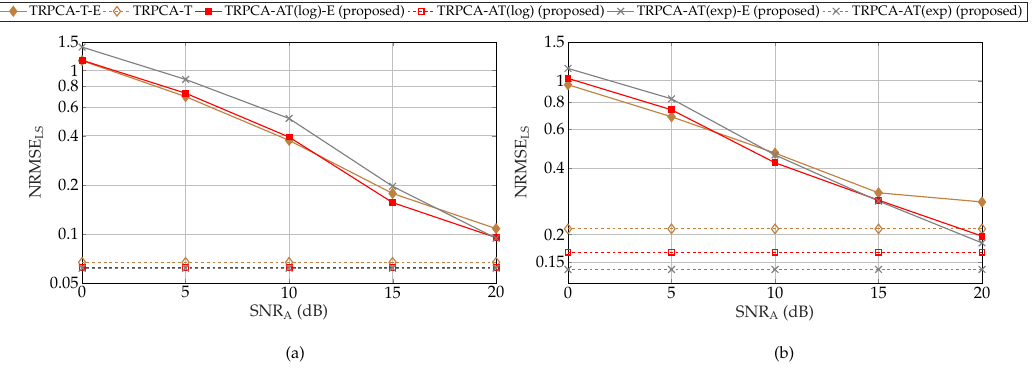
Figure 9. Average combined recovery error of low-rank and sparse matrices for compression ratio K / MN = 50% ( a ) and K / MN = 25% ( b ) with different model error levels for ADMM-based trained RPCA with thresholding (TRPCA-T), proposed ADMM-based trained RPCA with adaptive thresholding based on logarithm heuristic (TRPCA-AT(log)), and proposed ADMM-based trained RPCA with adaptive thresholding based on exponential heuristic (TRPCA-AT(exp)). Here, model error means that the train and testing samples are generated with different measurement matrices. For training, y = A vec ( L + S ) + n ; for testing, y = ¯ A vec ( L + S ) + n with ¯ A = A + E . The results with model error are represented by solid lines, whereas dotted lines indicates the results without model error ( E = 0 K , MN ).